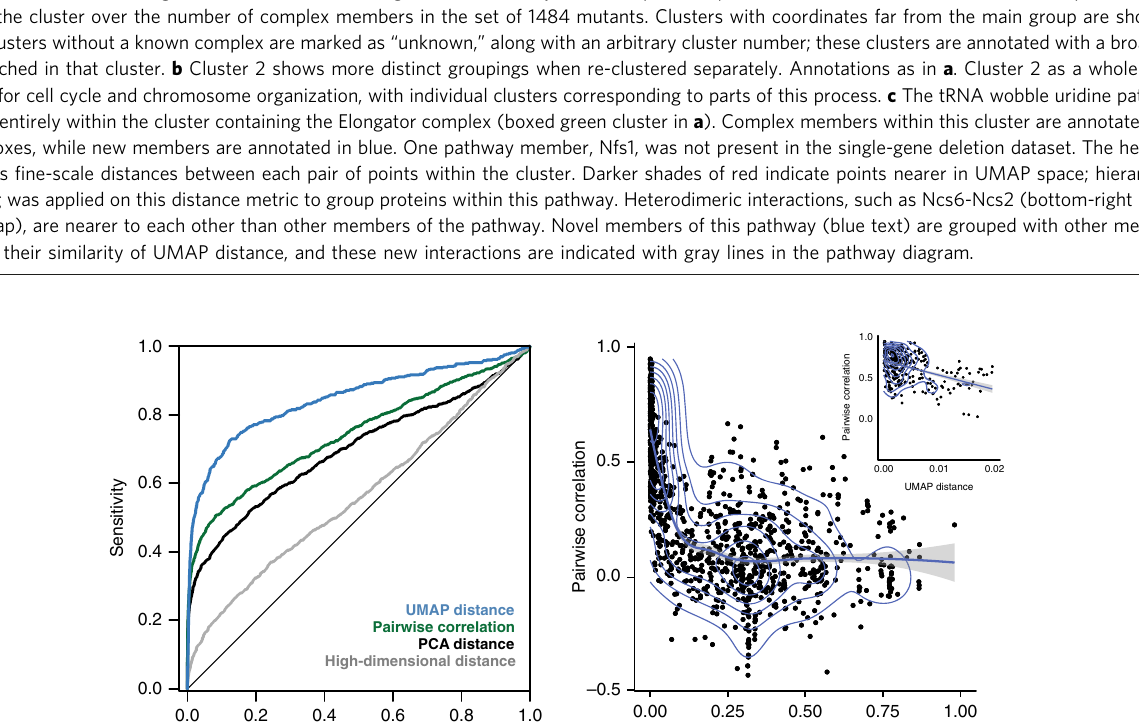
Fig. 2 UMAP distance identi fi es protein-protein interactions more effectively than previous methods. a A receiver-operator curve showing the ability of UMAP distance to capture known protein-protein interactions (sensitivity) as a function of its false positive detection. UMAP distance (blue) performs better than pairwise correlation (green), PCA distance (dark gray), and high-dimensional distance (light gray) in identifying interactions. b For each protein-protein interaction, the distance between points in UMAP space was plotted against the pairwise correlation of that pair of transcriptomes. The density of points is indicated with blue lines. Inset in the upper right shows a zoomed-in portion of the x -axis; points with UMAP distance in this range are highly enriched for true interactions that are not captured by pairwise